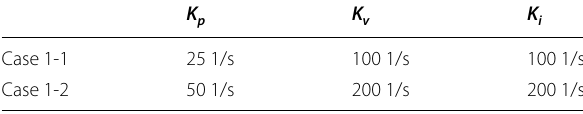
Table 5 Feedback loop gain for control method 1